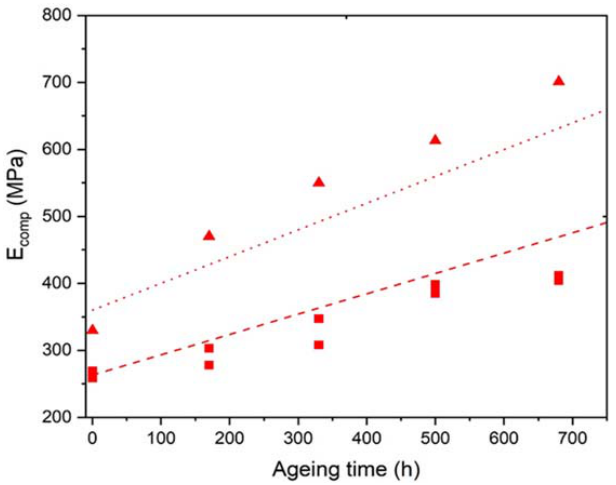
Figure 19. Kinetic modeling of the changes in the elastic modulus of the unfilled Si ‐ XLPE matrix ( □ ) and the composite material with 25 phr of ATH ( ∆ ), during their radio-thermal exposure in air under 400 Gy ∙ h − 1 at 21 °C.